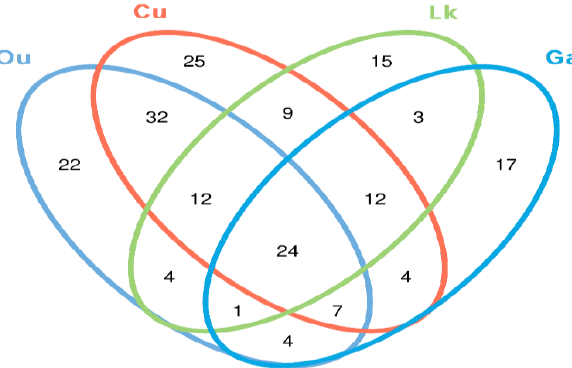
Figure 6. Venn diagram illustrates overlap of OTUs in gut microbiota among the four fish species. Ou: O. unifasciatus , Cu: C. urodeta , Lk: L. kasmira , Ga: G. aurolineatus .